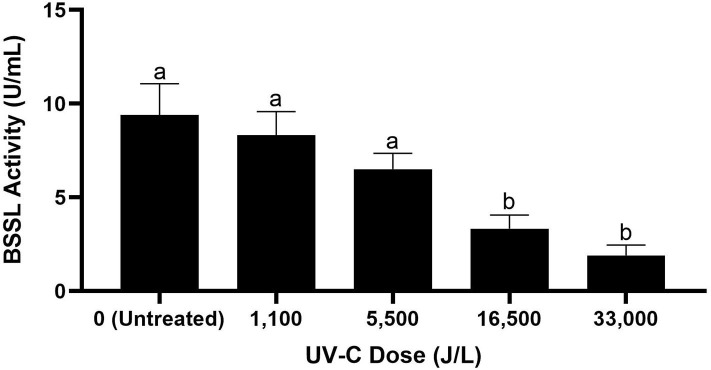
Bile salt-stimulated lipase activity in untreated donor breast milk and donor milk treated by UV-C at different exposure doses from 0 to 33,000 J/L. Different letters indicate that the samples are significantly different at p < 0.05.